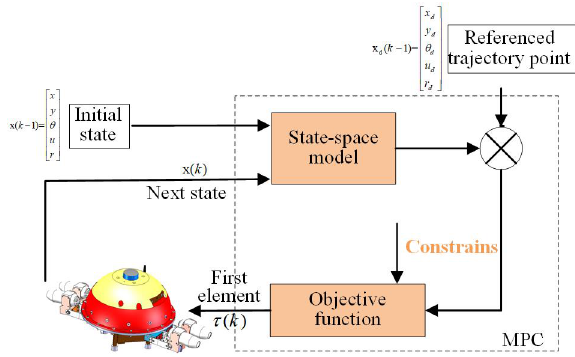
Figure 5. Diagram of the proposed model predictive control (MPC) controller for BSR trajectory